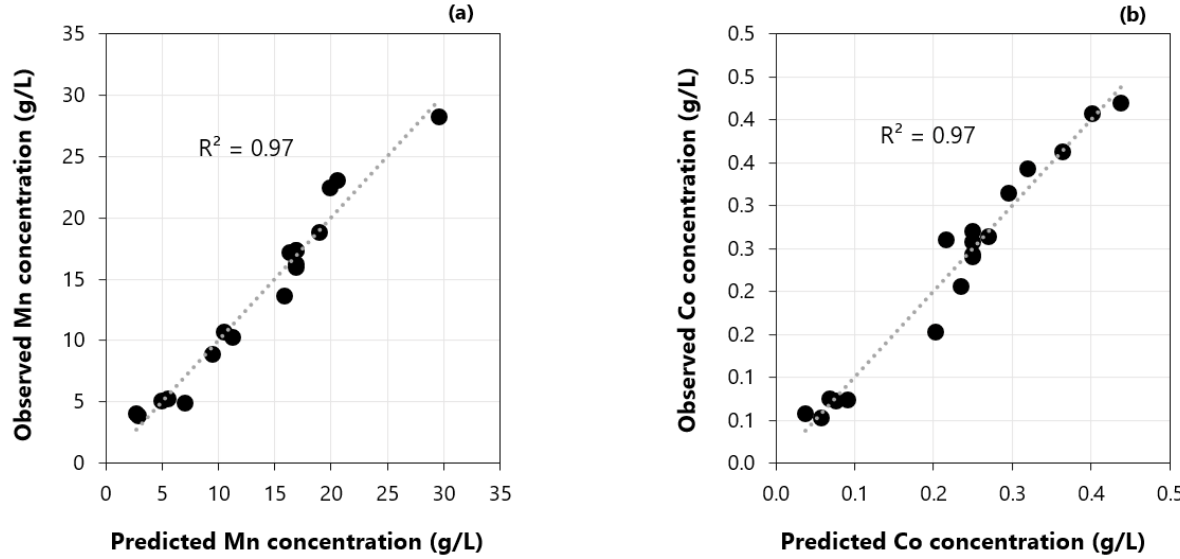
Figure 9. Responses predicted by the model versus experimentally observed: ( a ) manganese stripping and ( b ) cobalt stripping.